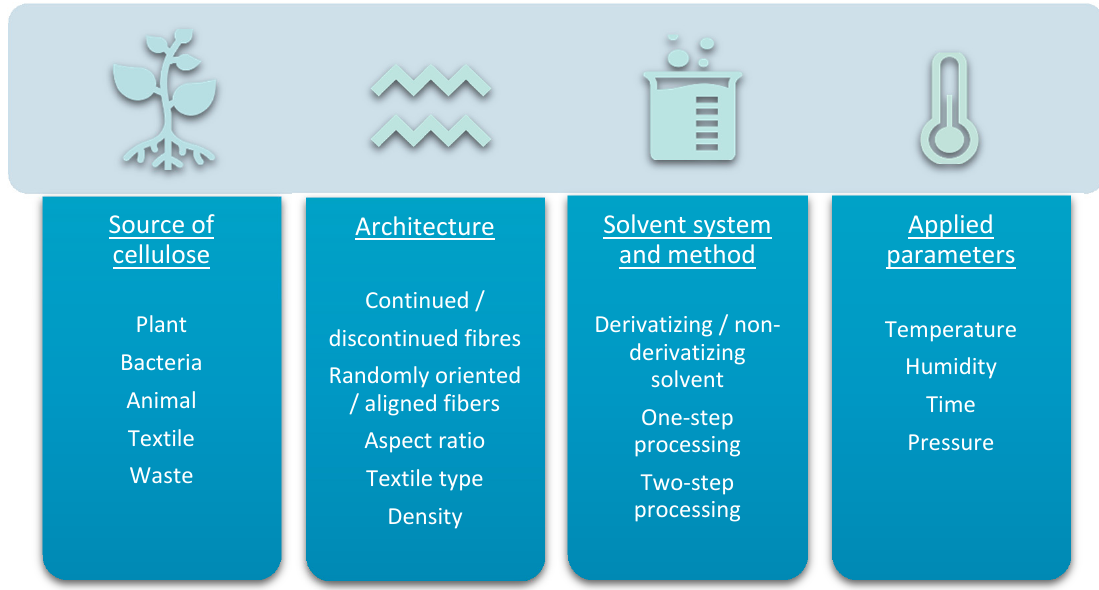
Figure 7. Physical and chemical properties of ACC depend on raw materials (and their compatibility), architecture of the composite, chosen solvent system, processing method and applied experimental conditions.